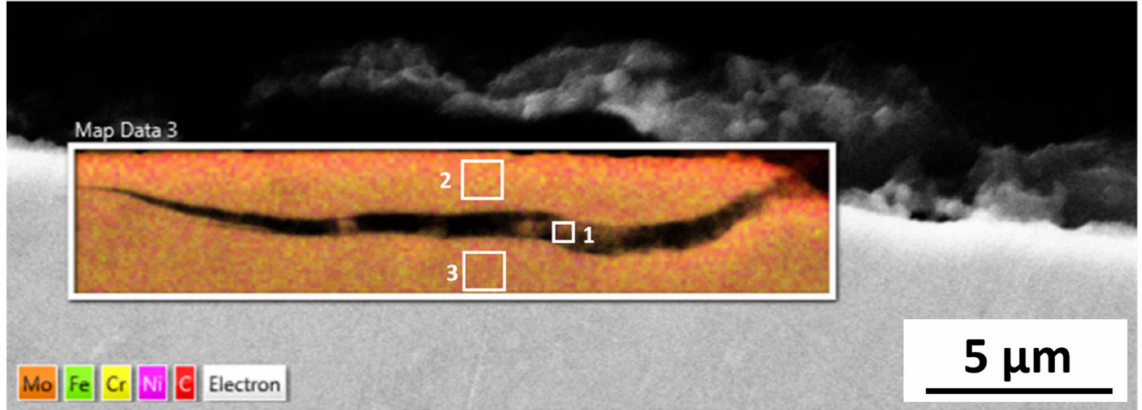
Figure 13. Microstructural analysis of Chaunoy-exposed Inconel 625 taken with SEM, where inclusions are seen within crack propagation in location 1. The colour map shows the relative composition of Mo, Fe, Cr, Ni and C in the